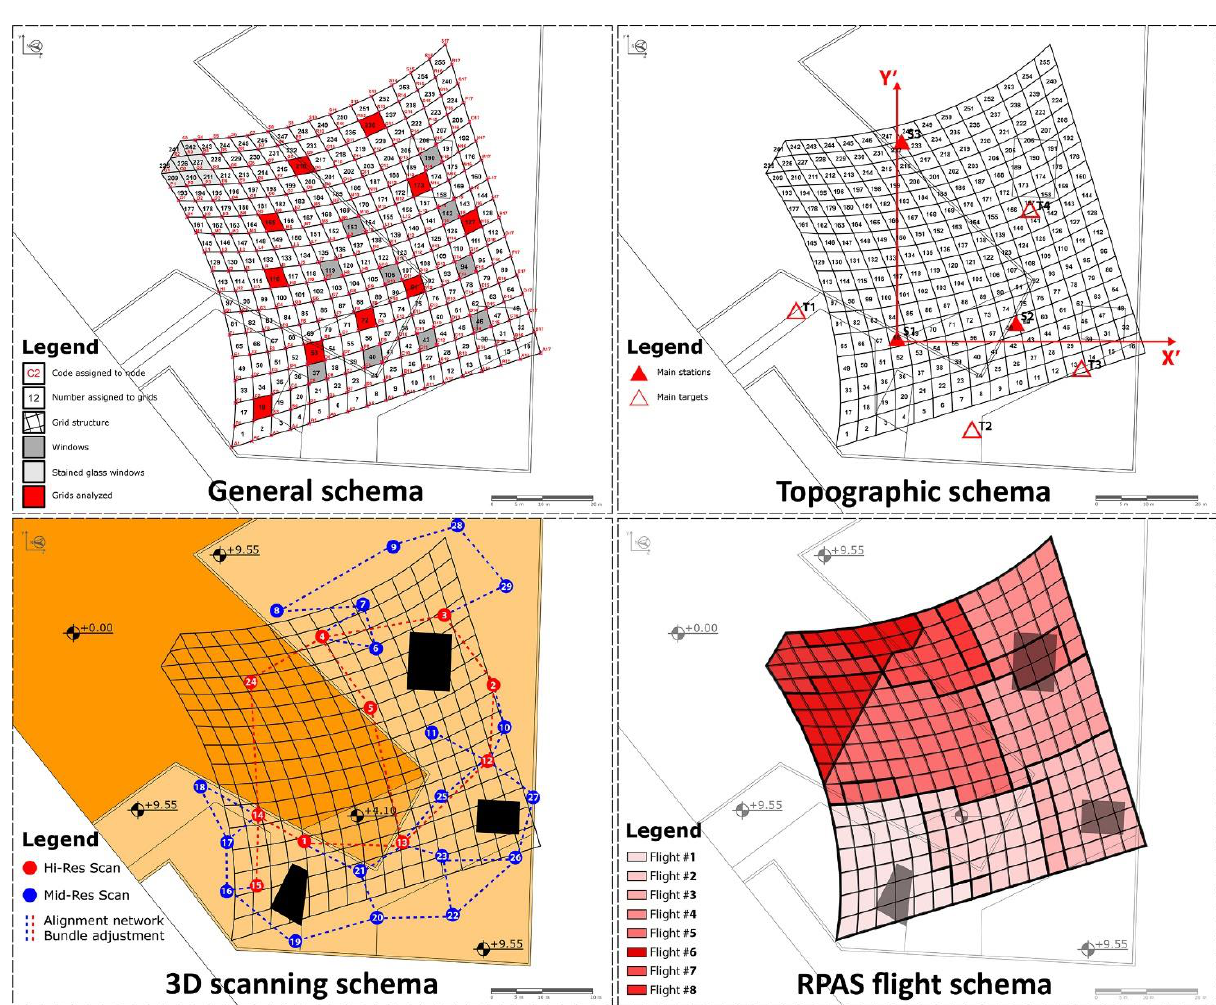
Figure 6: Structure schema, with its principal nomenclature and operational schemas of the survey